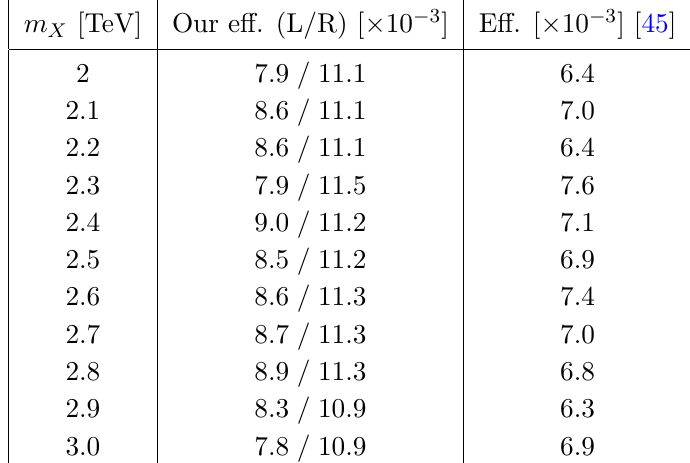
Table 4 . Selection e(cid:14)ciencies obtained through our simulation for the signal selection proposed in [45] for a pair produced X VLQ decaying into the Wt (cid:12)nal state compared with the one of [45].